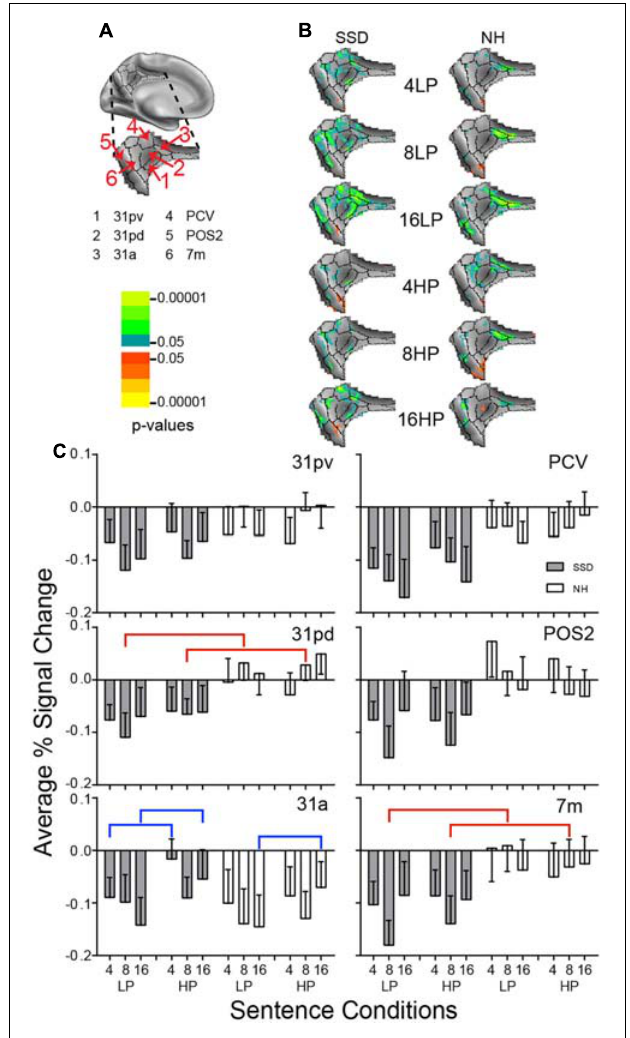
FIGURE 9 | Results from six parcels in the LH Posterior Cingulate Cortex (PCC) region. (A) Medial view of a partially inflated hemisphere shows the PCC region. (B) Enlarged views of parcels show clusters with significant mean z-scores of p < 0.05 for positive BOLD (colored red-orange to bright yellow) and negative BOLD scaled blue to light green. (C) 31pd and 7m had significant group effects marked with red brackets. 31a had a significant predictability effect marked by a blue